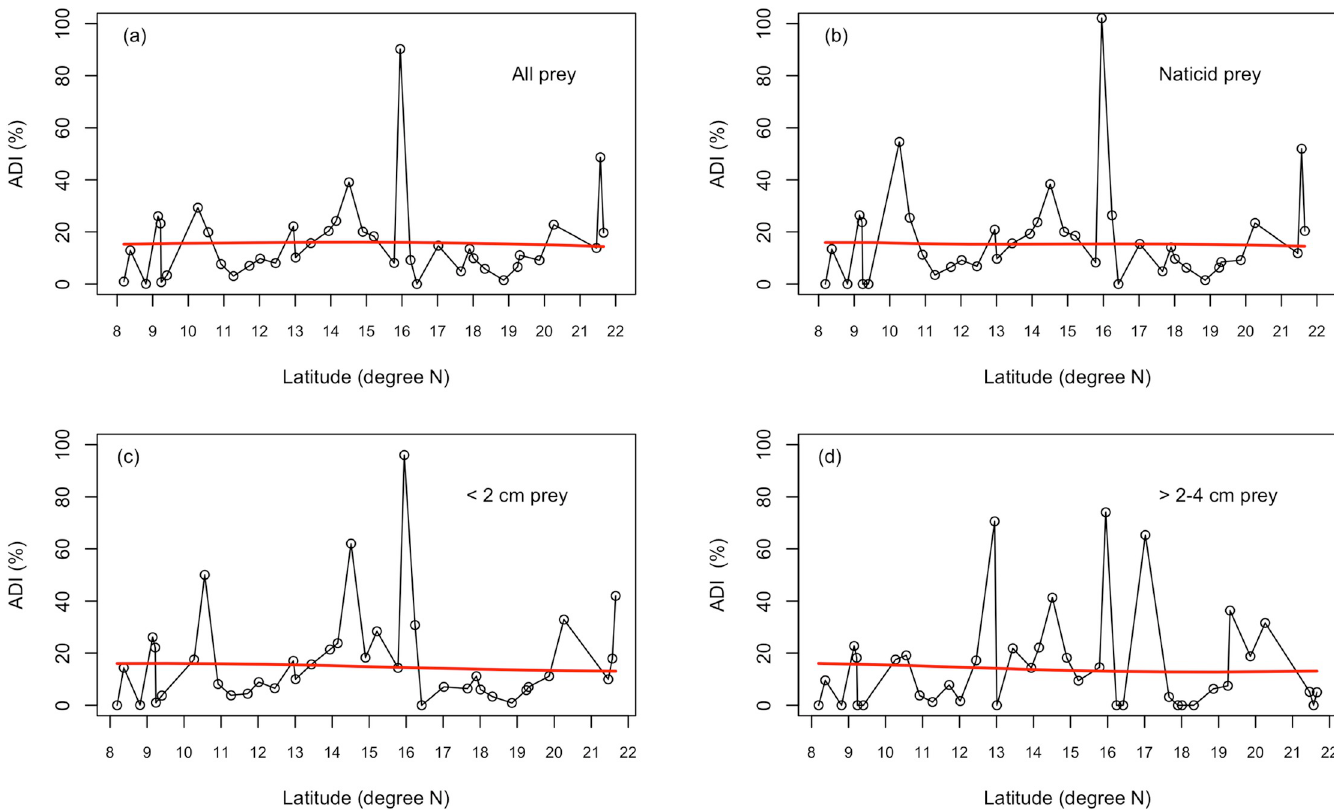
Fig 3. Latitudinal variation in assemblage drilling intensities (ADI) on molluscs along the eastern coast of India shows no latitudinal pattern. Note, the LOESS-fit trend line (in red) is always flat, i.e., for all prey taxa (a), only when infaunas are considered (i.e., naticid prey (b)), when two smaller size classes (c-d) are considered.